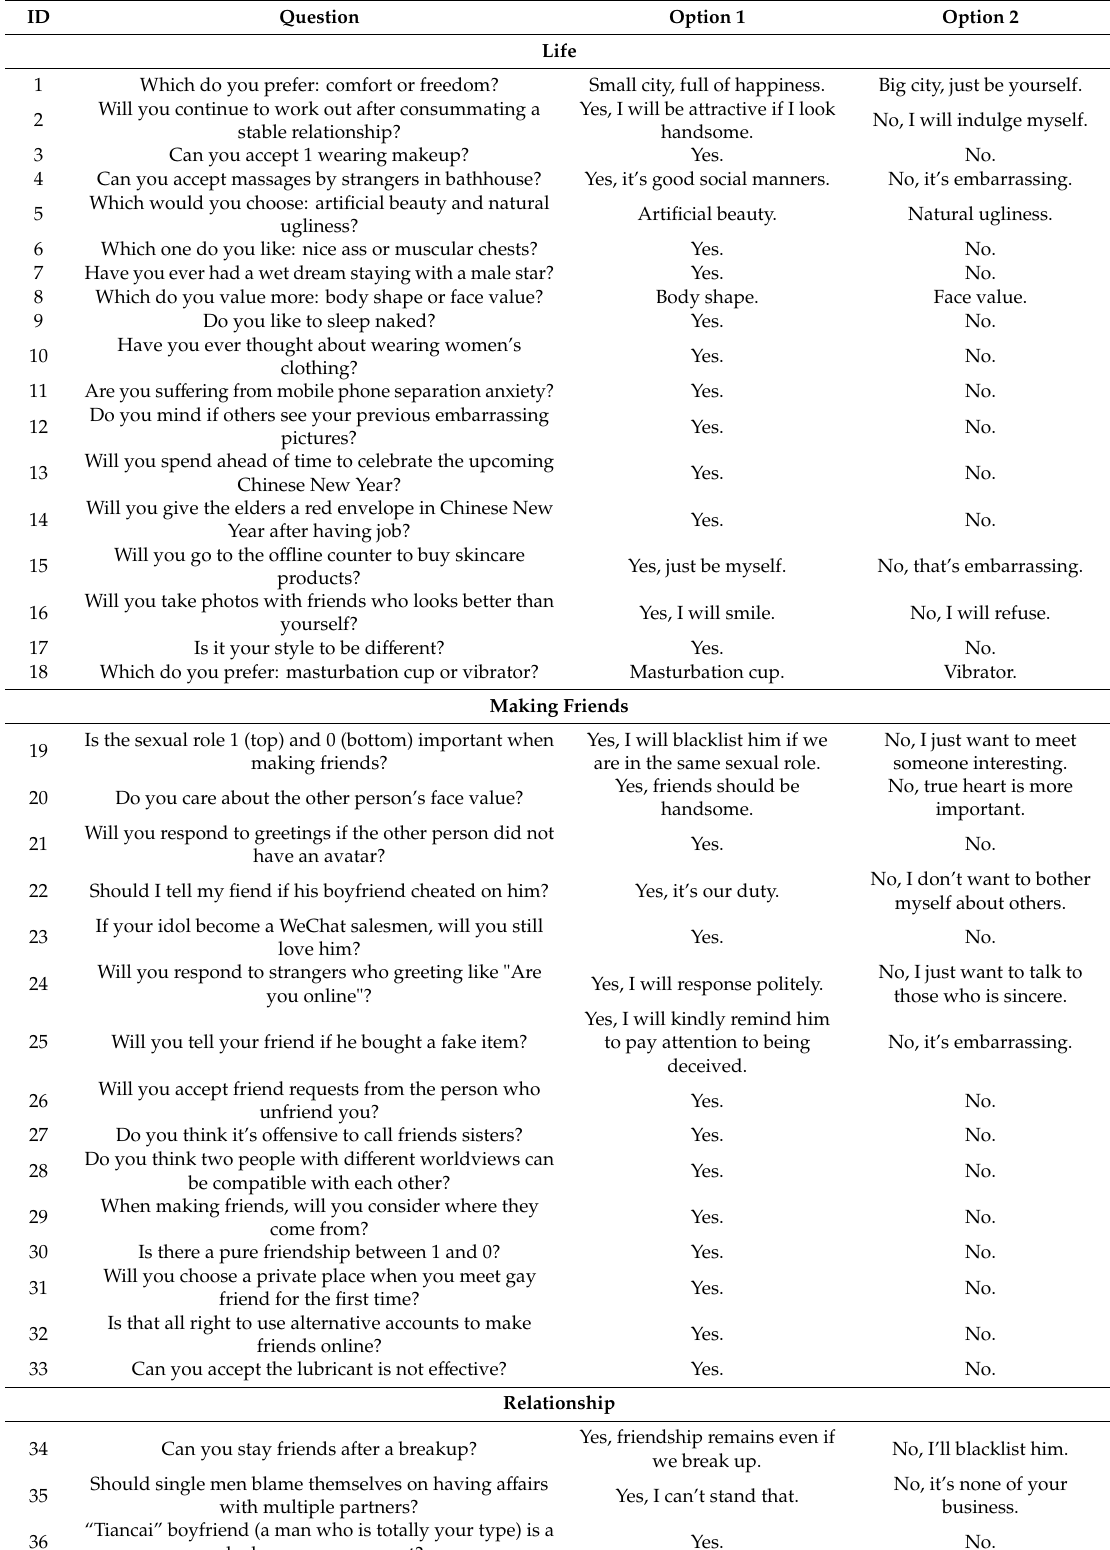
Table A1. A comprehensive list of voting questionnaires on